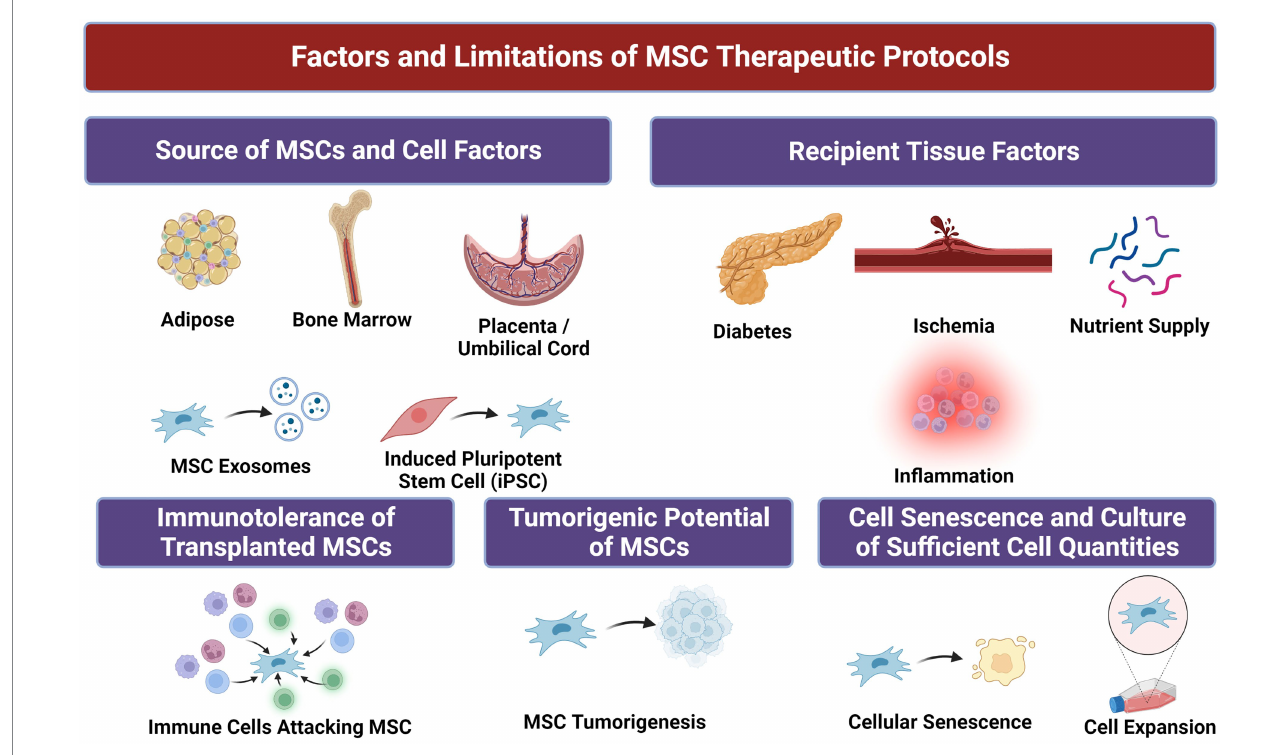
FIGURE 2 Factors and associated limitations of mesenchymal stem/stromal cells (MSCs) for therapeutic purposes.